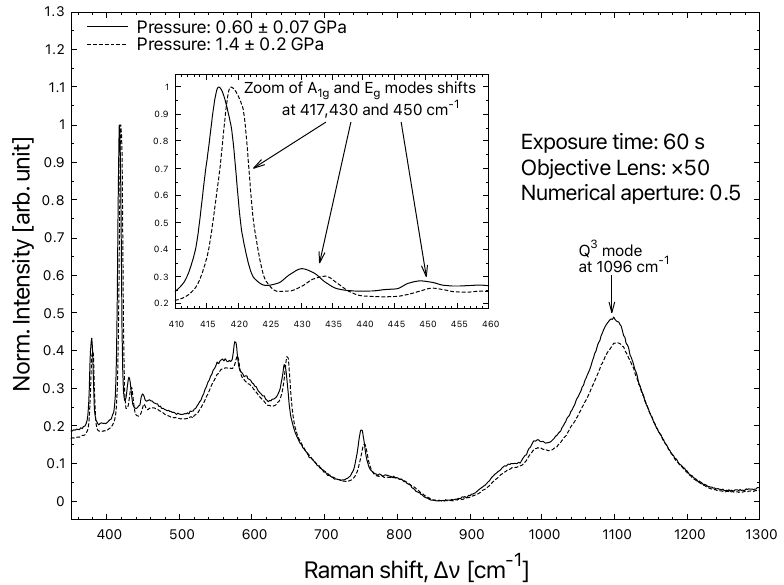
Figure 6. The shift of the Raman spectrum was recorded at the alumina–glass interface for two pressure conditions: at 0.6 GPa (solid line) and 1.4 GPa (dashed line). The enlargement shows the region between 410 and 440 cm − 1